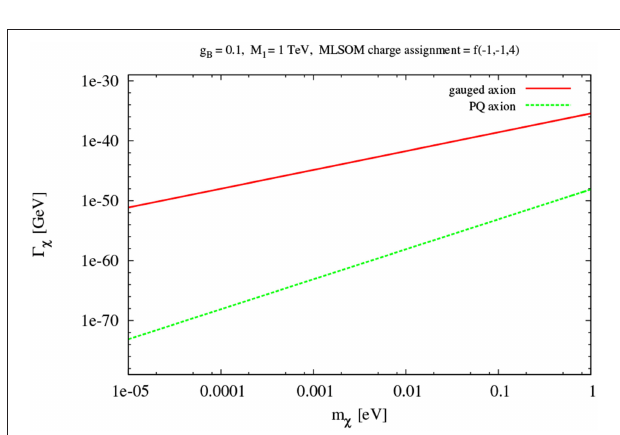
FIGURE 2 | Contributions to the χ contribution (A) and the interaction mediated by the Yukava coupling in the fermion loop (B) .